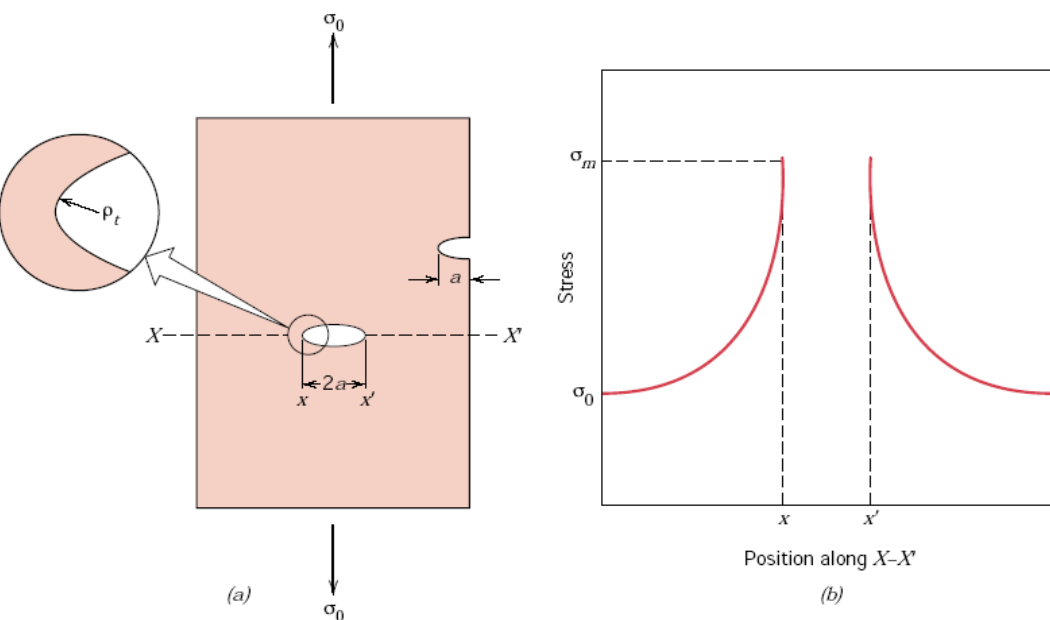
Figure 2. ( a ) The geometry of surface and internal cracks; ( b ) Schematic stress profile of an internal crack (along the line X–X’ in ( a )), demonstrating stress amplification at crack tip positions. Reproduced with permission from [3], Springer, 2009.